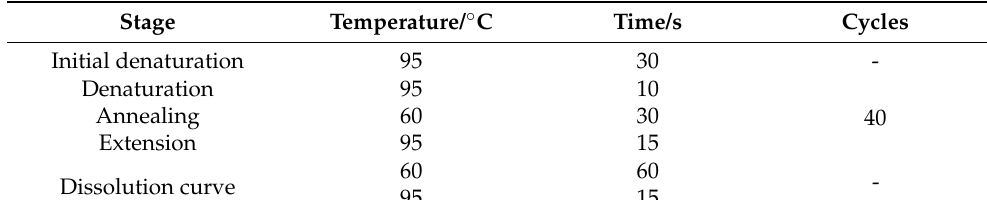
Table A3. Reaction program of qPCR.